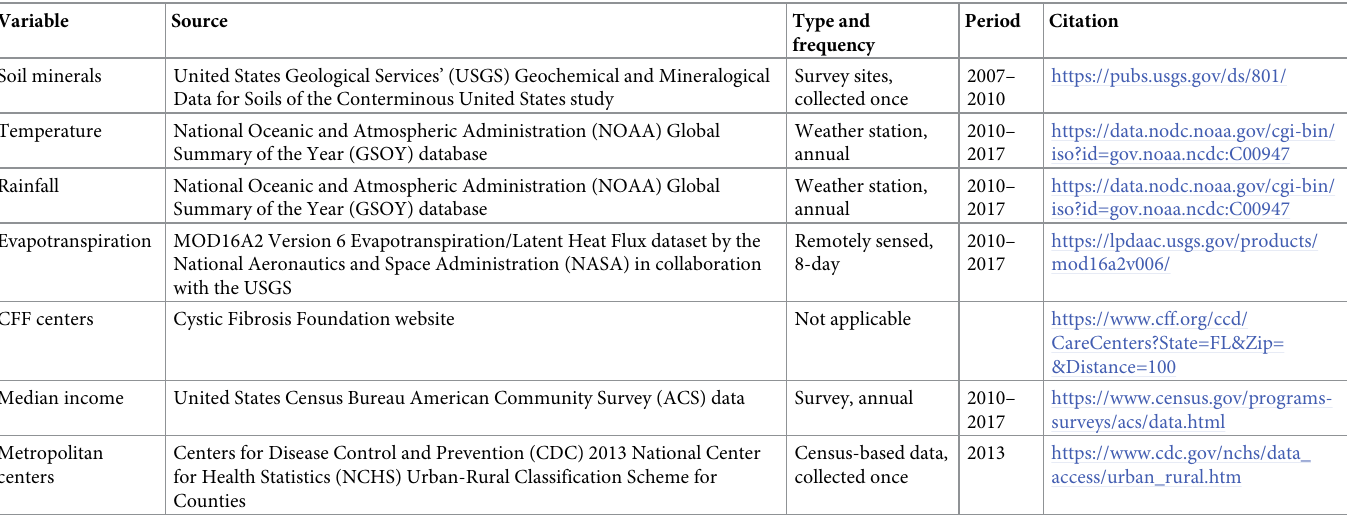
Table 1. Data sources for variables used in